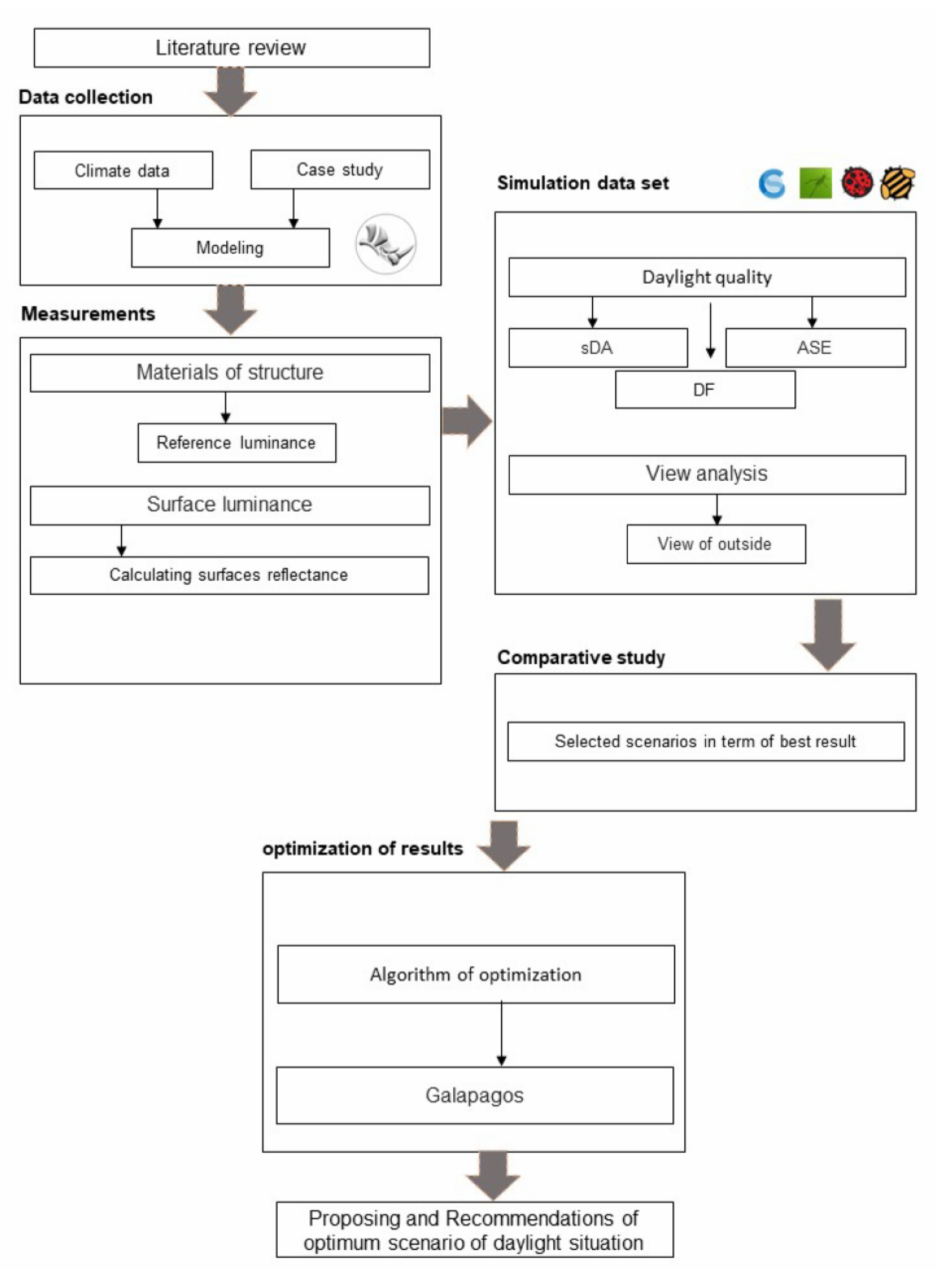
Figure 4. Conceptual framework of the